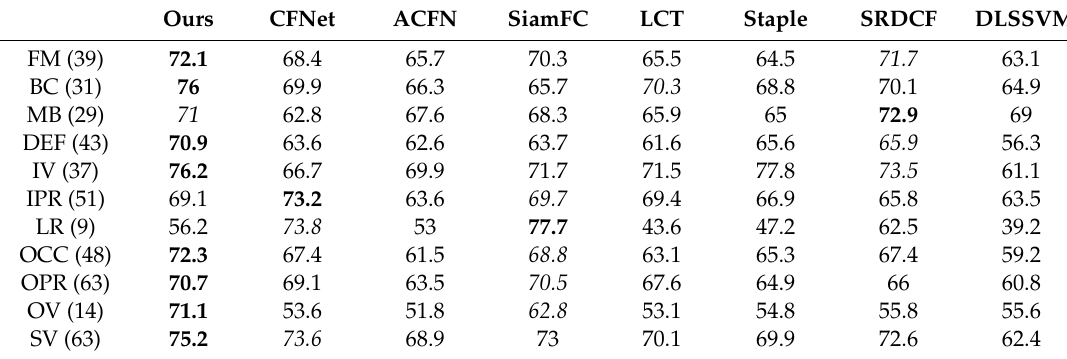
Table 6. Overlap success rate (%) of 11 di ff erent attributes on OTB2015 dataset. Ours CFNet ACFN SiamFC LCT Staple